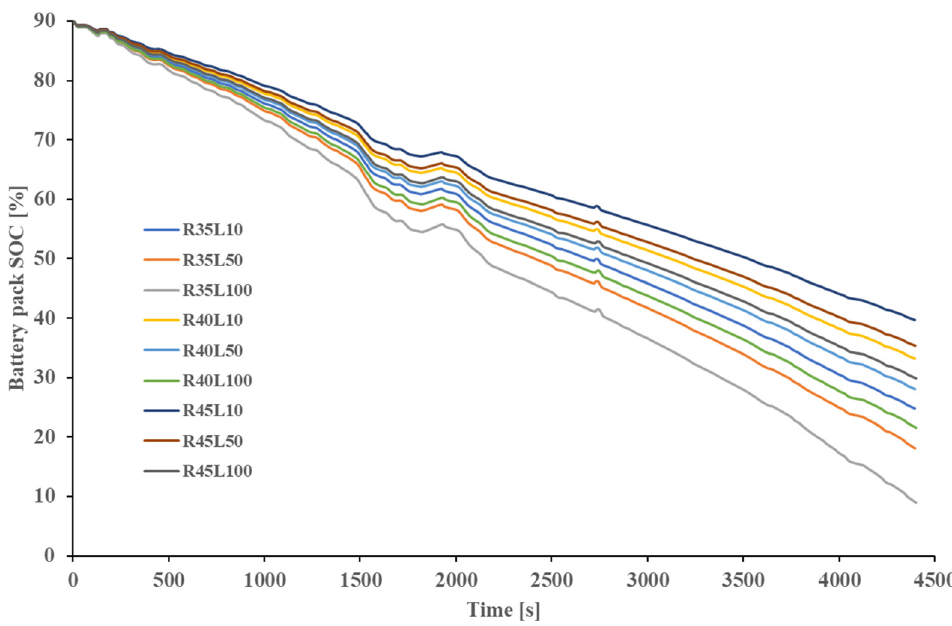
Figure 12. The battery pack SOC variations during travel for different scenarios.